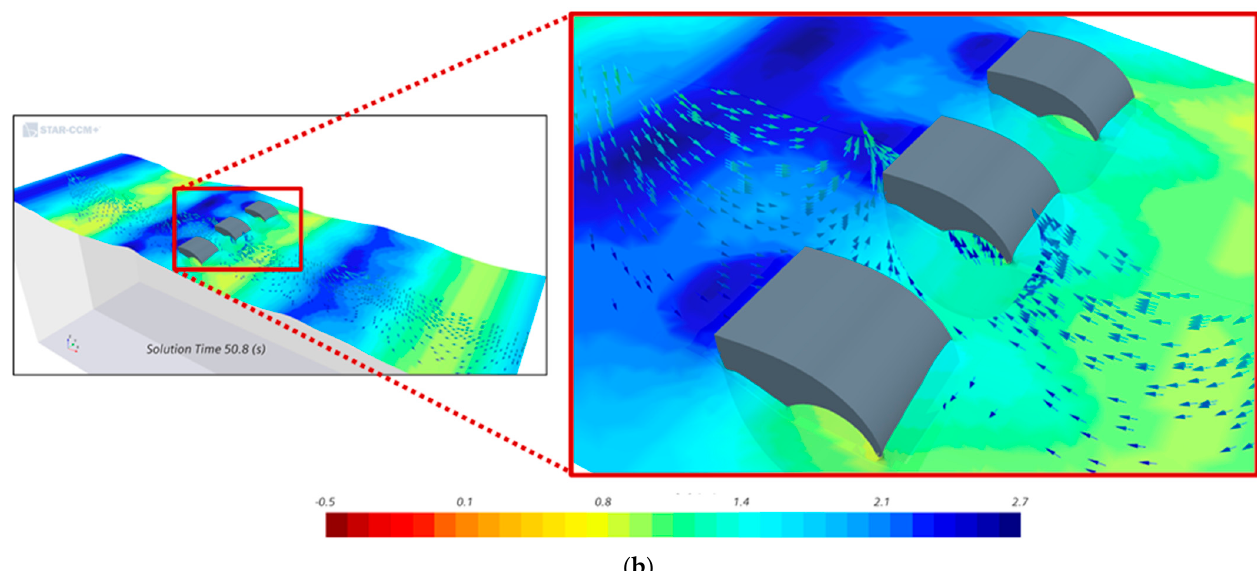
Figure 12. Comparison of the free surface wave elevation along the NWT for multiple WEC rotors: ( a ) ω = 1.20 rad/s and ( b ) ω = 1.32 rad/s.